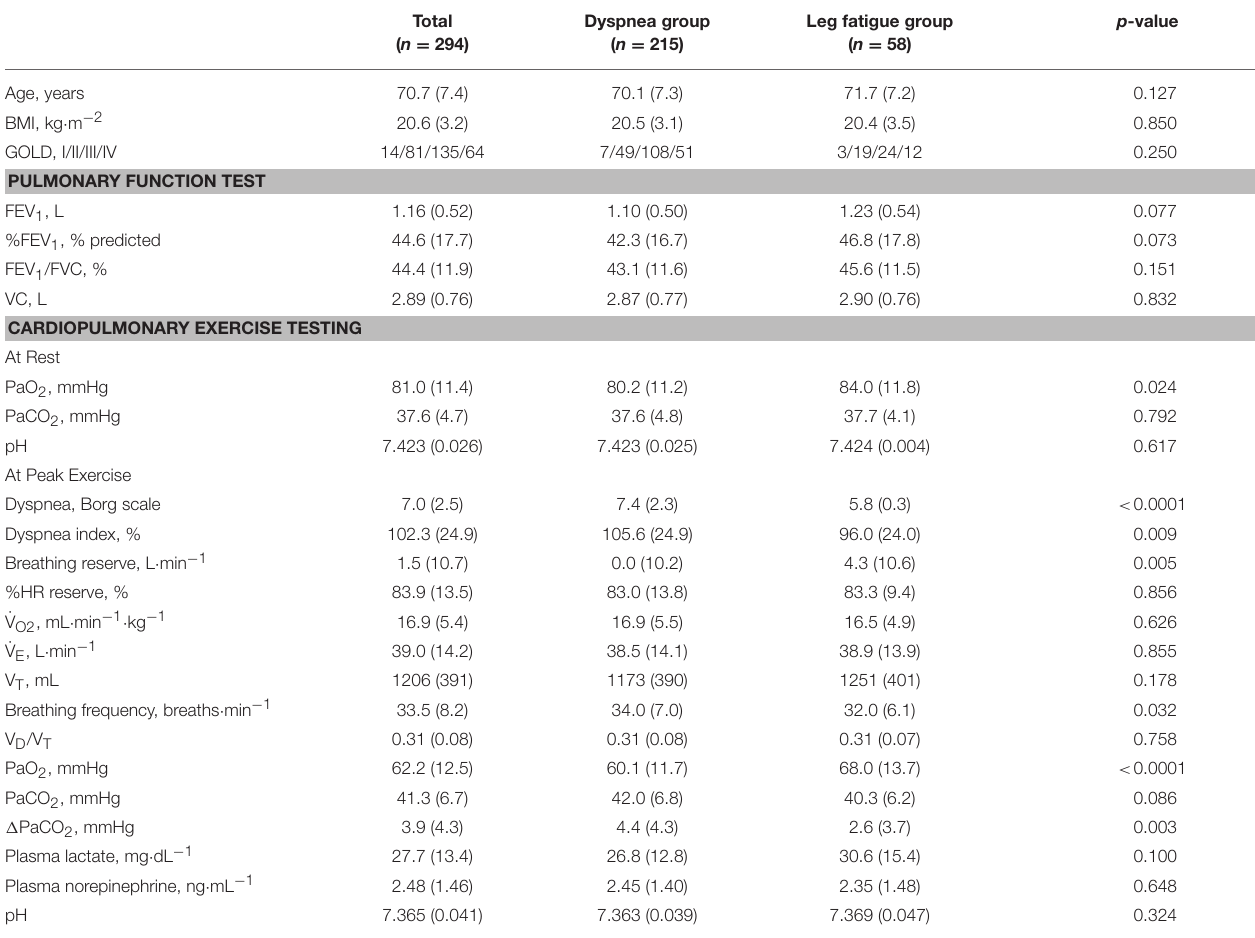
TABLE 1 | Baseline characteristics of the study